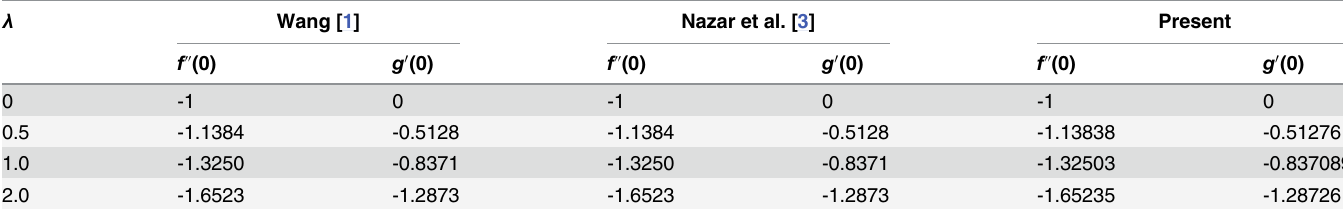
Table 3. Comparison of current result with previous studies for special cases ( ϕ = 0, M = 0).